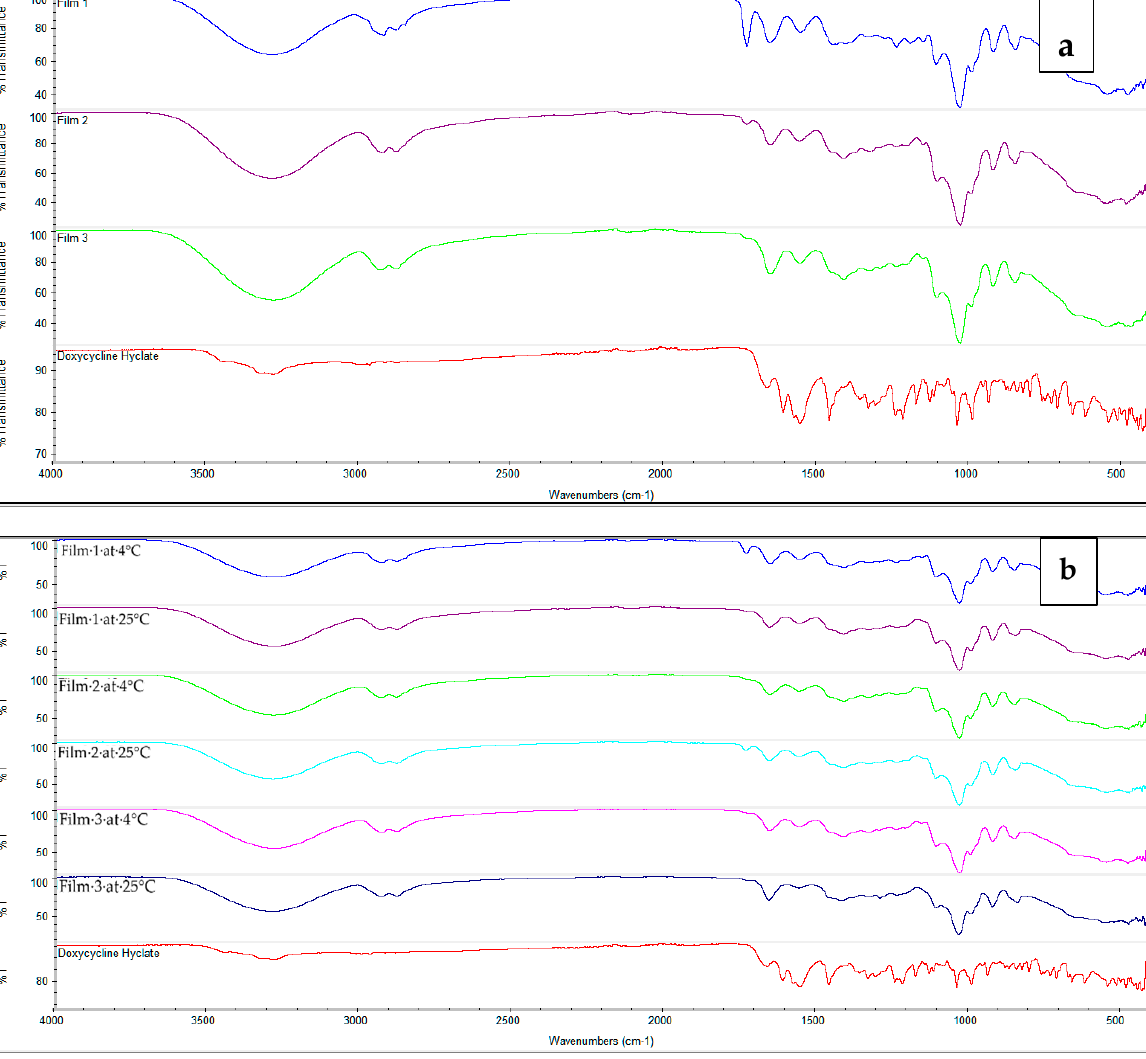
Commented [M1]: Please update the subfigure 4b. Thank you.